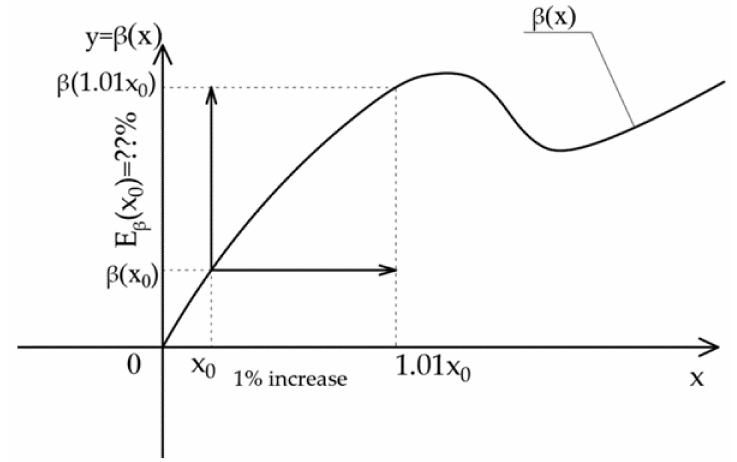
Figure 2. Illustration of the elasticity of the function β (x) of one variable